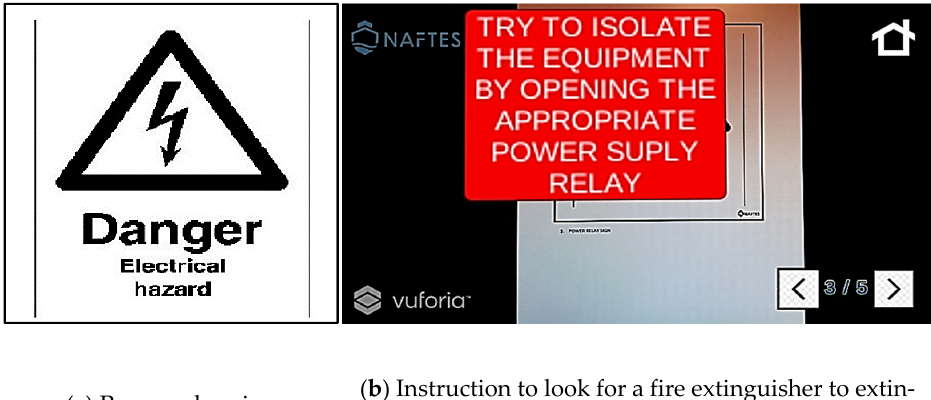
Figure 2. Second screen of a scenario of fire on an electrical circuit. ( a ) Printed target sign, and ( b ) the corresponding instructions that appear in the firefighters’ view.